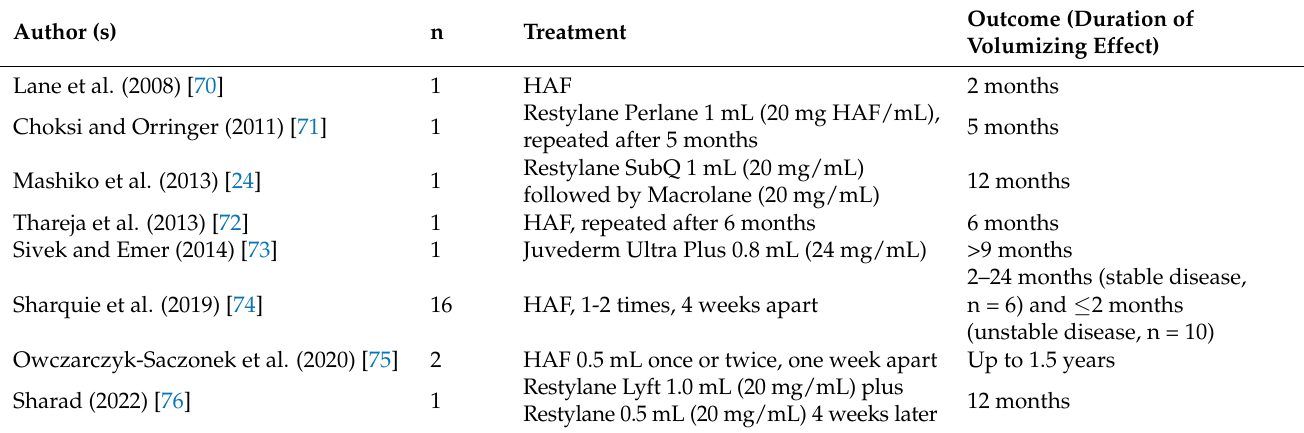
Table 6. HAF for correction of facial morphea (morphea en coup de